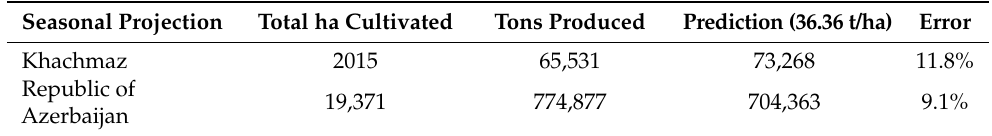
Table 19. The projections on a regional and national level, using the most recent statistic data reports (source: